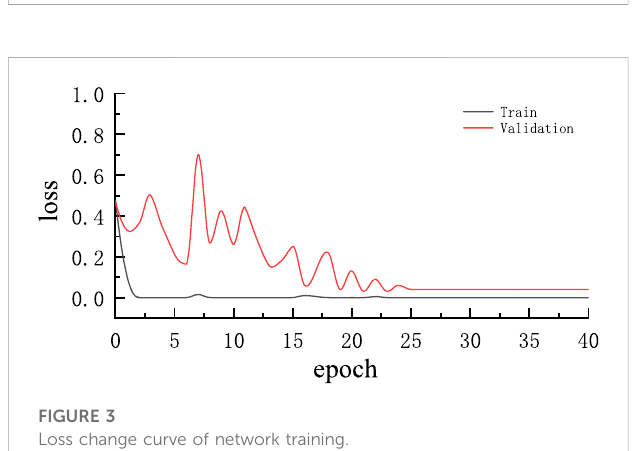
FIGURE 2 Accuracy curve of network training.